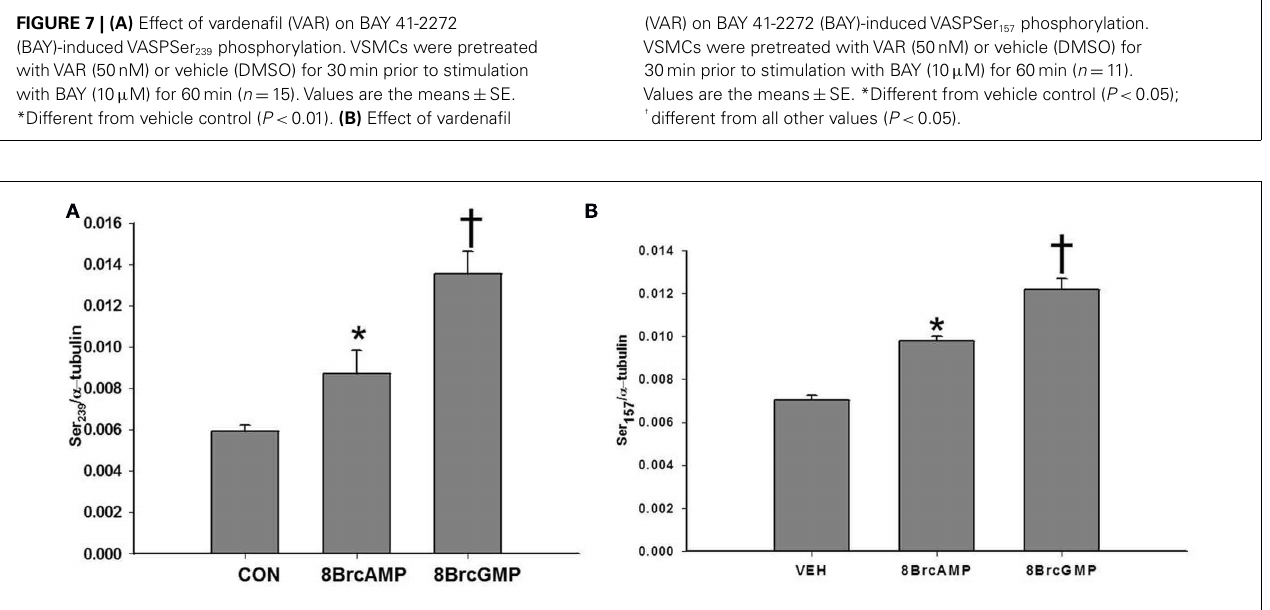
FIGURE 8 | (A) Effect of 8Br-cAMP and 8Br-cGMP onVASPSer 239 phosphorylation.VSMCs were treated with 8Br-cAMP (10 μ M), 8Br-cGMP (10 μ M), or vehicle (PBS) for 30min ( n = 3).Values are the means ± SE. *Different from vehicle control ( P < 0.05); † different from all other values